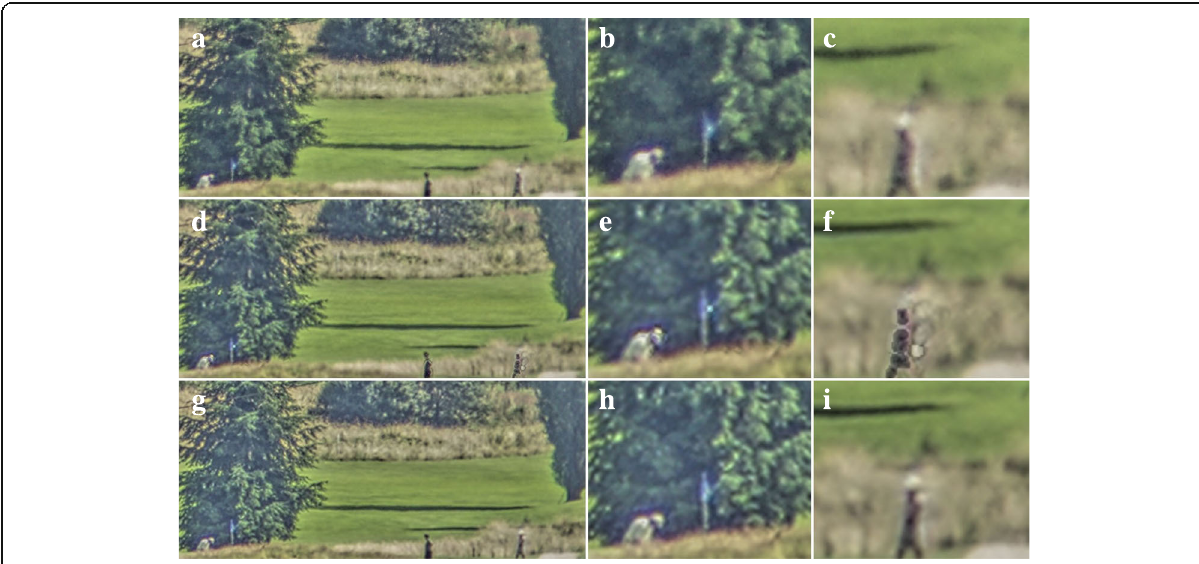
Fig. 7 Turbulence mitigation on a golf course scene. The top row shows a still from the raw video ( a ) and two cut-outs around the hole ( b ) and a walking golf player ( c ). The middle row shows the processing results with the global turbulence mitigation method and the bottom row shows the result for dynamic turbulence mitigation with TV-L1 optical flow. The walking golf player is about 25 × 70 pixels in